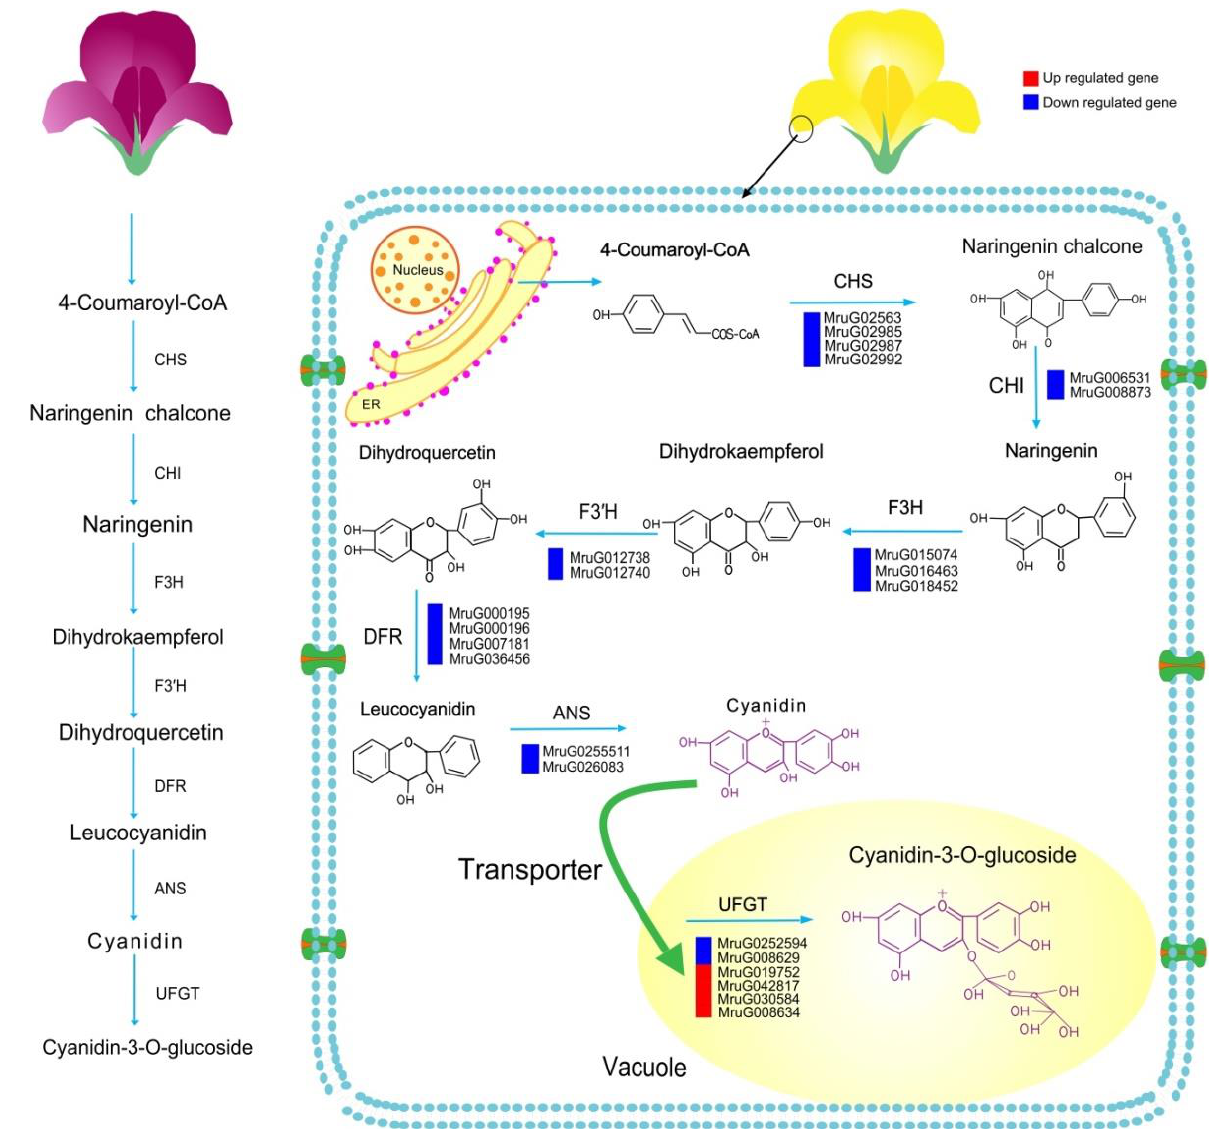
Figure 7. Model representing the anthocyanin synthesis process in the M. ruthenica species. In this study, PFMs served as the control group. The referred model for a better understanding of the formation of the pale-yellow M. ruthenica flower was drawn using Adobe Illustrator 2019. ER represents the endoplasmic reticulum. The crucial candidate gene IDs are indicated at the side of related enzymes. Blue-colored grids indicate the downregulated genes, and red-colored grids indicate upregulated genes. The arrow refers to the steps of the anthocyanin biosynthesis pathway (ABP). CHS , CHI , F3H , and F3′H were upstream genes involved in the ABP. DFR , ANS , and UFGT were downstream genes involved in the ABP. Briefly, the low expression level of 4 CHS, 2 CHI, 3 F3H , 2 F3′H , 4 DFR , 2 ANS , and 2 UFGT might disrupt the anthocyanin synthesis, leading to the formation of the pale-yellow petals seen in YFM. UFGT catalyzes the last step of the ABP, the UFGT enzyme glycolyzed anthocyanidin into anthocyanin by adding sugar moieties, thereby increasing the hydrophilicity and stability of anthocyanin.